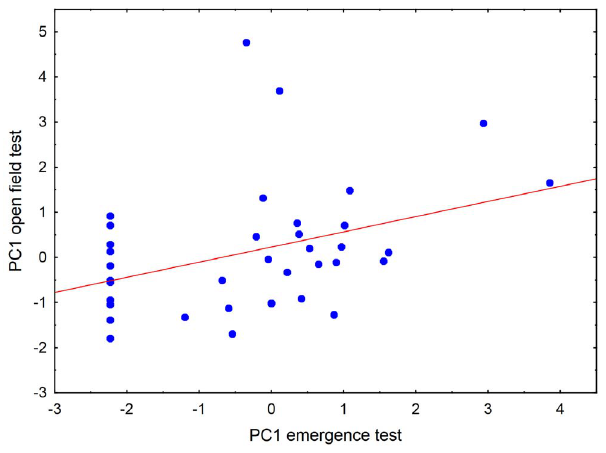
Figure 3. Correlation between individual behaviour in two different assays. Boldness scores (PC1 from the first run), calculated from principal component analyses, of two-spotted goby males tested in an emergence test and an open field test, respectively (r s =0.39, p=0.015, N=38).